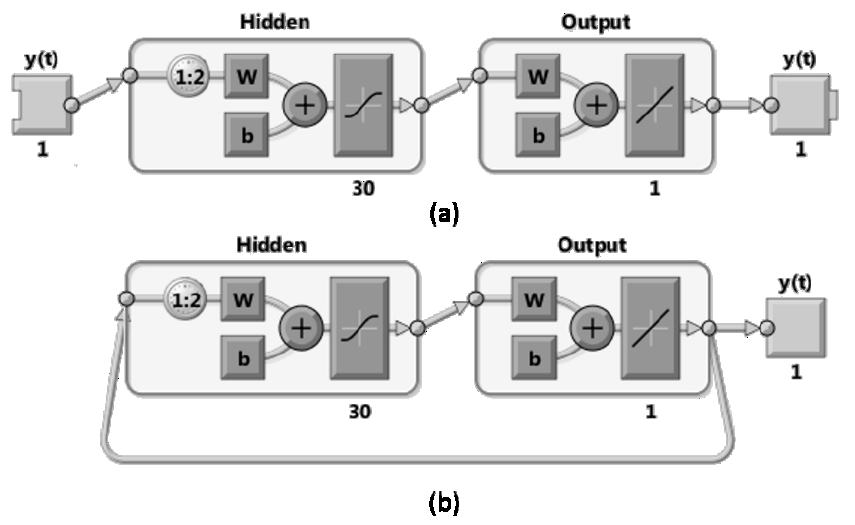
Figure 1. Architecture of the open ( a ) and closed loop ( b ) of nonlinear autoregressive neural network. Mathematically, the model forecasts future values of a time series y ( t ), based on its historical values y ( t − 1), y ( t − 2), ..., y ( t − d ), (NAR model) utilizing additionally an external time series x ( t − 1), x ( t − 2), ..., x ( t − d ) (NARX model), where d is the time delay parameter.